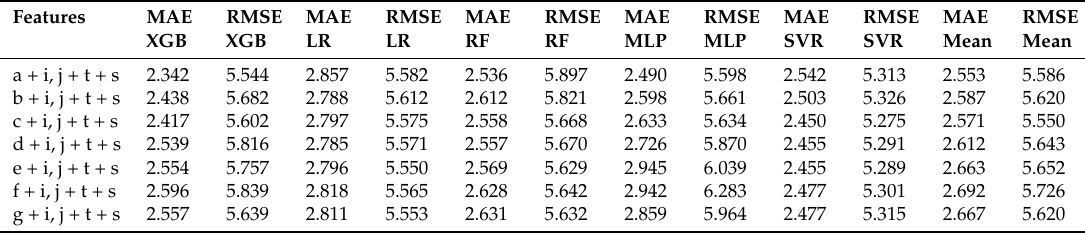
Table 4. RMSE and MAE using the same feature sets as Table 3 and square root rescaling, using five different machine-learning